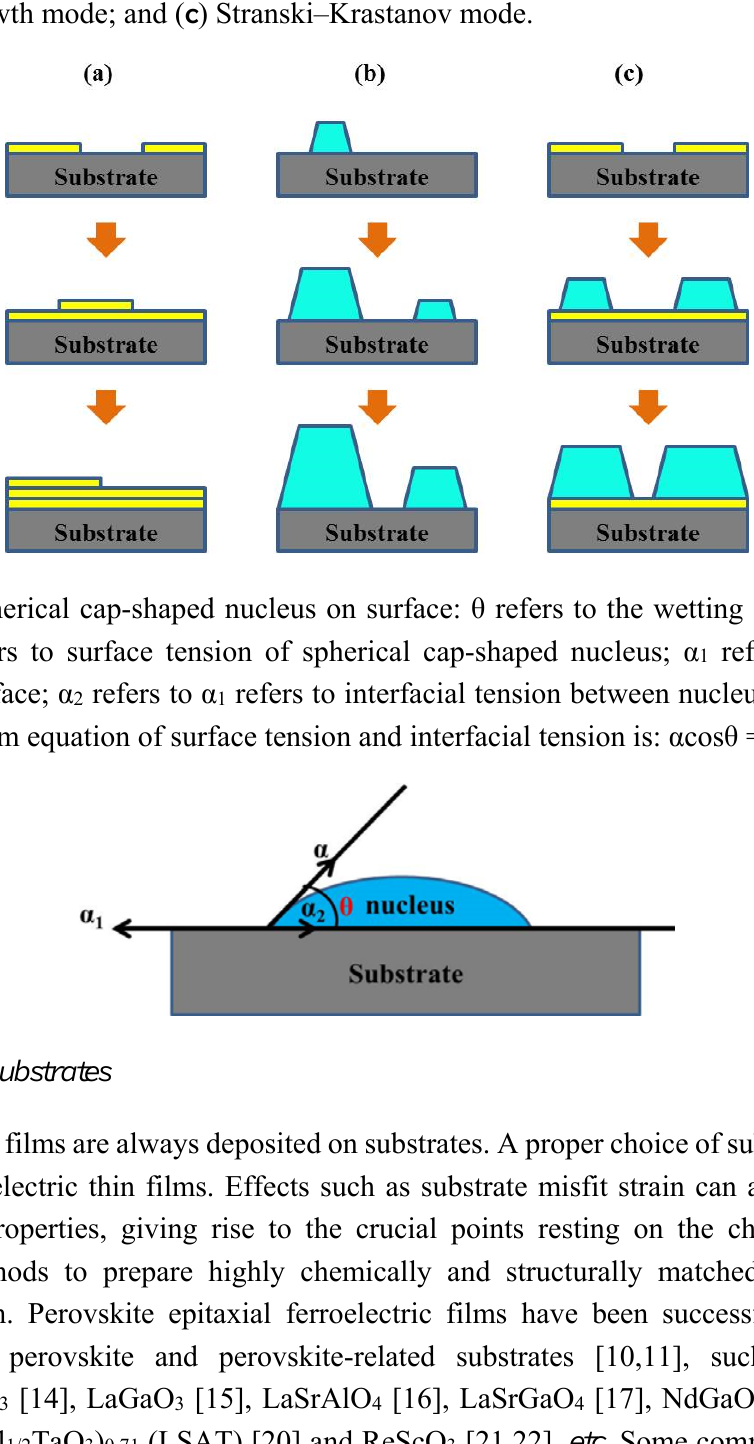
Figure 1. Schematic diagram of three basic growth modes: ( a ) layer-by-layer growth mode; ( b ) island growth mode; and ( c ) Stranski–Krastanov mode.